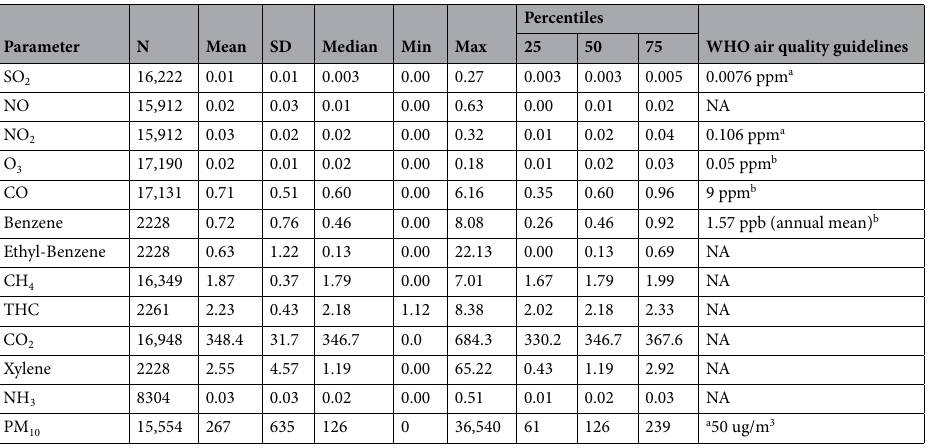
1. Descriptive statistics of various parameters. PM10 is in µg/m 3 , Benzene, Ethyl-benzene and Xylene are in PPB, whereas all other gaseous pollutants are in PPM. a Update of WHO air quality guidelines Michal Krzyzanowski & Aaron Cohen, Air Qual Atmos Health (2008) 1:7–13. b Air quality guidelines for Europe; second edition. NA not Available.